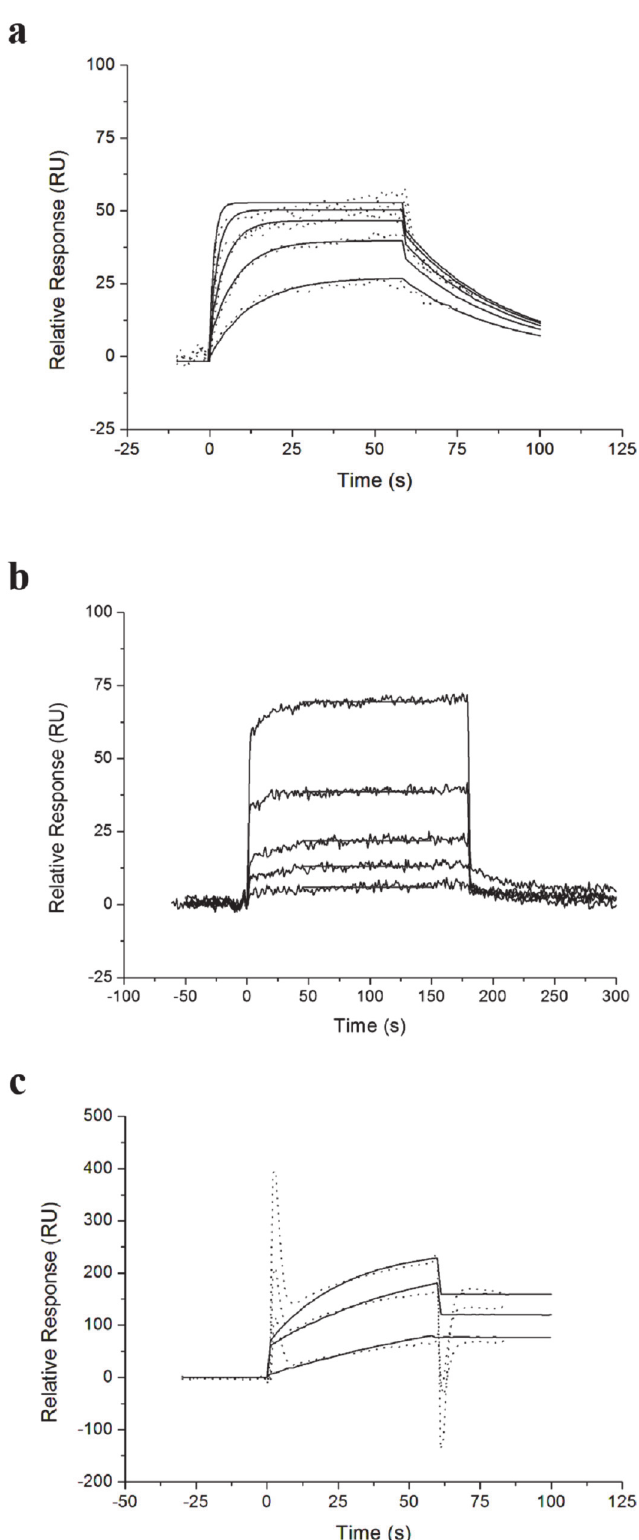
Fig 2. SPR sensorgrams of ligands to EGFR immobilized surface. (a) EGF to EGFR. (b) GE11 to EGFR. (c) mAb to EGFR.